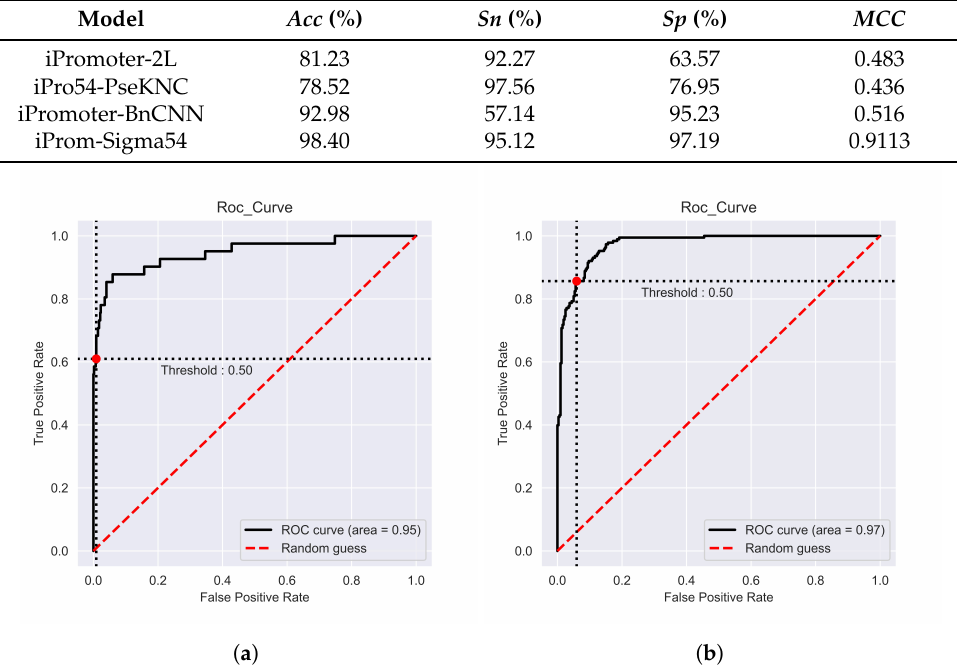
Figure 3. Receiver Operating Characteristic (ROC) curves The AUC ranges from 0.5 (for a random classifier) to 1 (for a perfect classifier): ( a ): ROC Curve on 5 fold ( b ): ROC Curve on Test